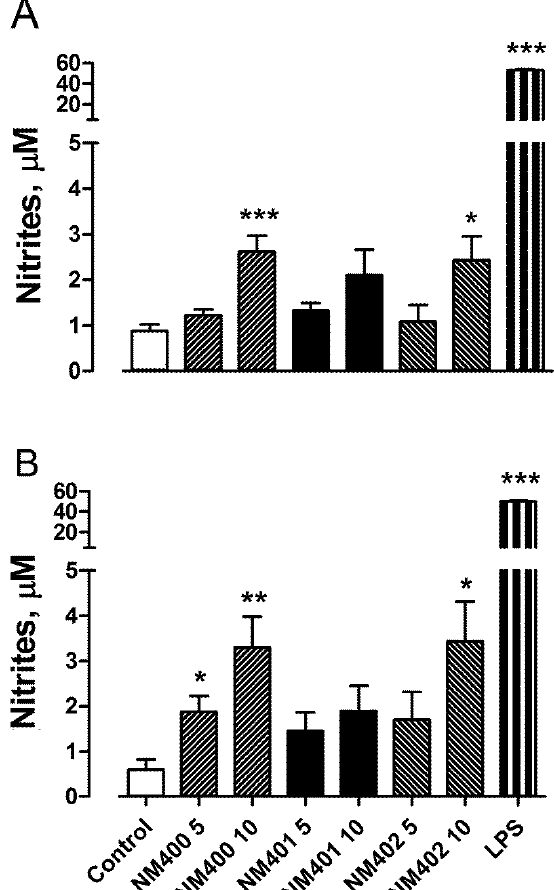
Figure 4. E ff ects of MWCNT on NO production in Raw264.7 and MH-S cells. Raw264.7 ( A ) and MH-S ( B ) macrophages, grown for 24 h in complete growth medium, were treated for 72 h with 5 or 10 µ g / cm 2 of NM-400, NM-401, or NM-402, or with LPS (100 ng / mL), used as a positive control. At the end of treatment, nitrite concentration was determined in the culture medium. Data are the means of seven independent determinations ± S.D. * p < 0.05, ** p < 0.01, and *** p < 0.001 vs. untreated, control cells, as determined with the t -test for unpaired data.